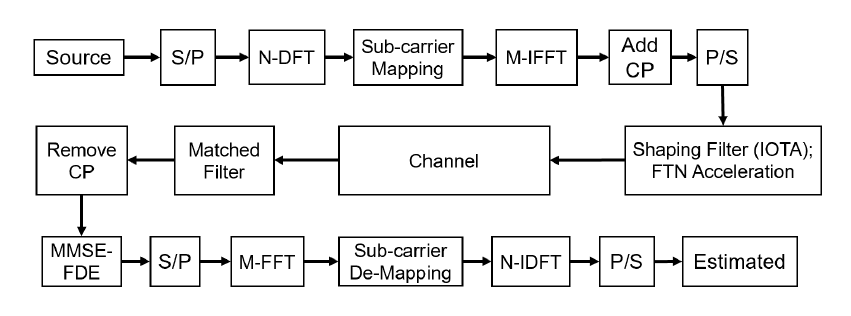
Figure 3. The transceiver design of the proposed